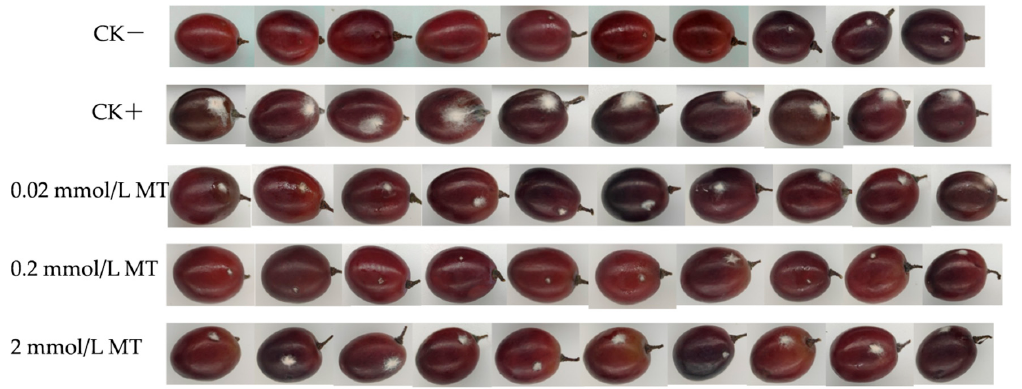
Figure 2. Effect of melatonin treatment on lesion development in infected “Muscat Hamburg” berries on day 3. Photographs depicting representative disease development were taken on day 3.